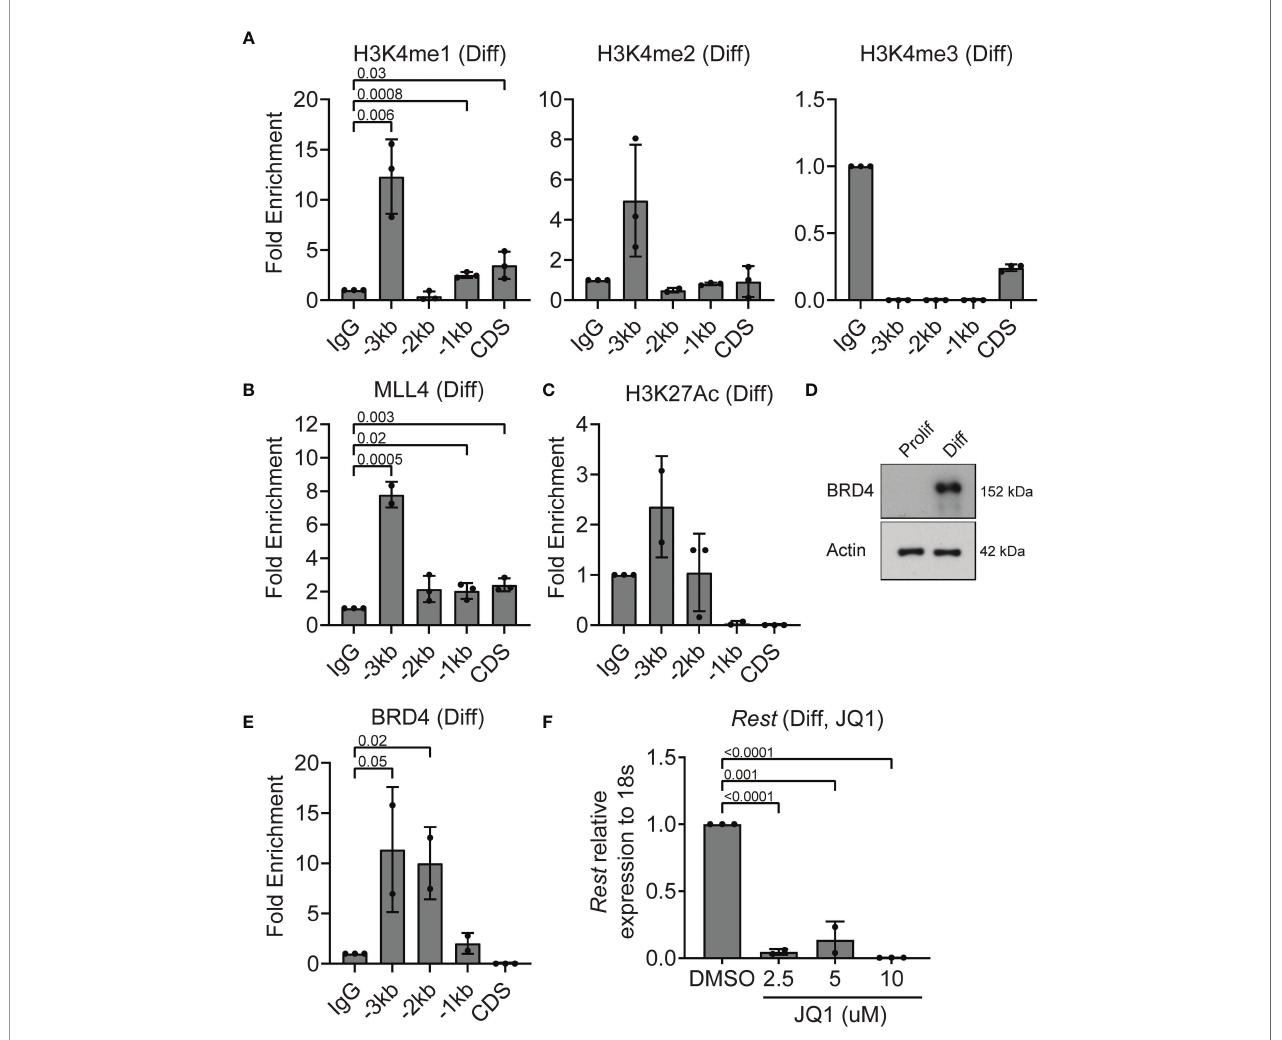
FIGURE 4 | MLL4 activity at the REST locus is diminished in differentiating CGNPs. (A) H3K4me1, 2 and 3 levels were measured by ChIP-qPCR and plotted as fold enrichment over IgG in differentiating progenitors. (B) ChIP-qPCR showing enrichment of MLL4 at the REST promoter represented as fold change over IgG. (C) H3K27Ac was measured by ChIP-qPCR in differentiating progenitors and plotted as fold enrichment over IgG (n = 4 for differentiating progenitors). (D) Western blot analysis of BRD4 protein in proliferating and differentiating progenitors and ACTIN as loading control. Blot shown is a representative from n=2. (E) ChIP-qPCR showing enrichment of BRD4 at the REST promoter represented as fold change over IgG. (F) Effect of BRD4 inhibition with JQ1 on REST mRNA was shown by qRT-PCR in DMSO and JQ1 treated progenitors in differentiating conditions (n =